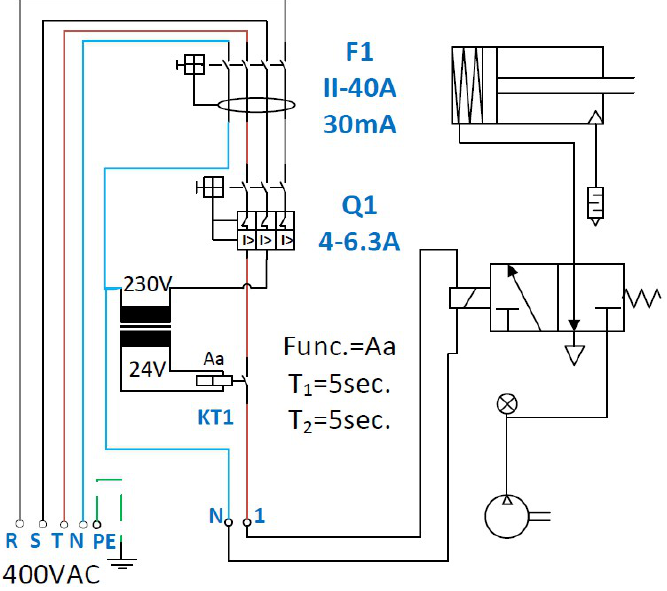
Figure 14. Schematics of the testing set for the pneumatic valve according to the protocol at the Fluidra group. Contains the solenoid valve, the piston and the compressor.